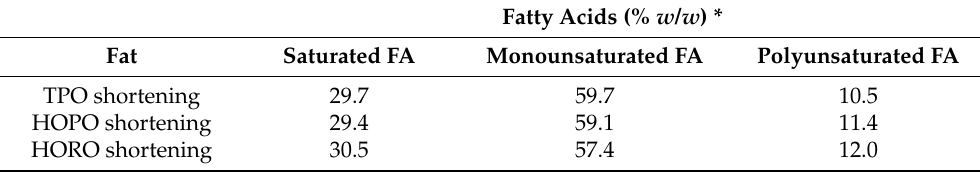
Table 3. Calculated fatty acid proportions (% w / w ) of produced shortenings. Fatty Acids (% w / w ) * Fat Saturated FA Monounsaturated FA Polyunsaturated FA TPO shortening 29.7 59.7 10.5 HOPO shortening 29.4 59.1 11.4 HORO shortening 30.5 57.4